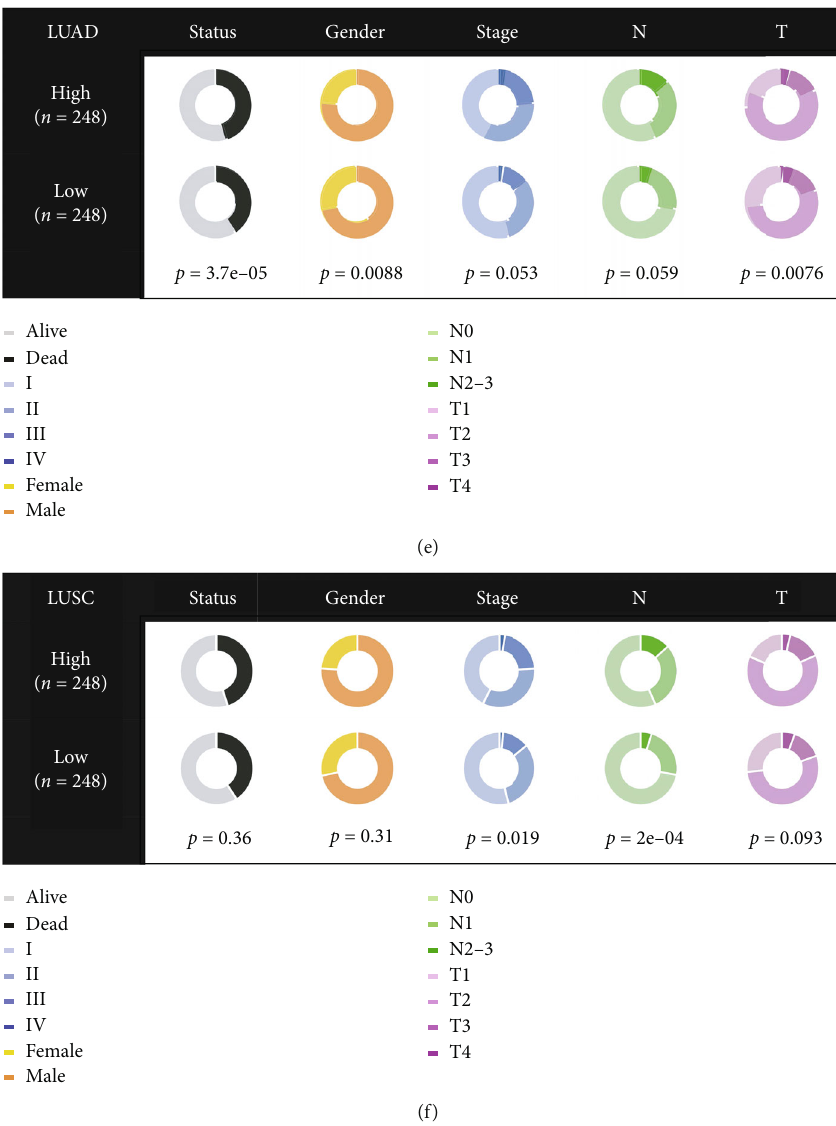
Figure 2: NEIL3 was upregulated in lung cancer and was associated with worse clinical features. Notes: (a – d) a higher NEIL3 expression was found in LUAD, LUAD+GTEx, LUSC, and LUSC+GTEx cohorts; (e, f) clinical correlation of NEIL3 in TCGA-LUAD and